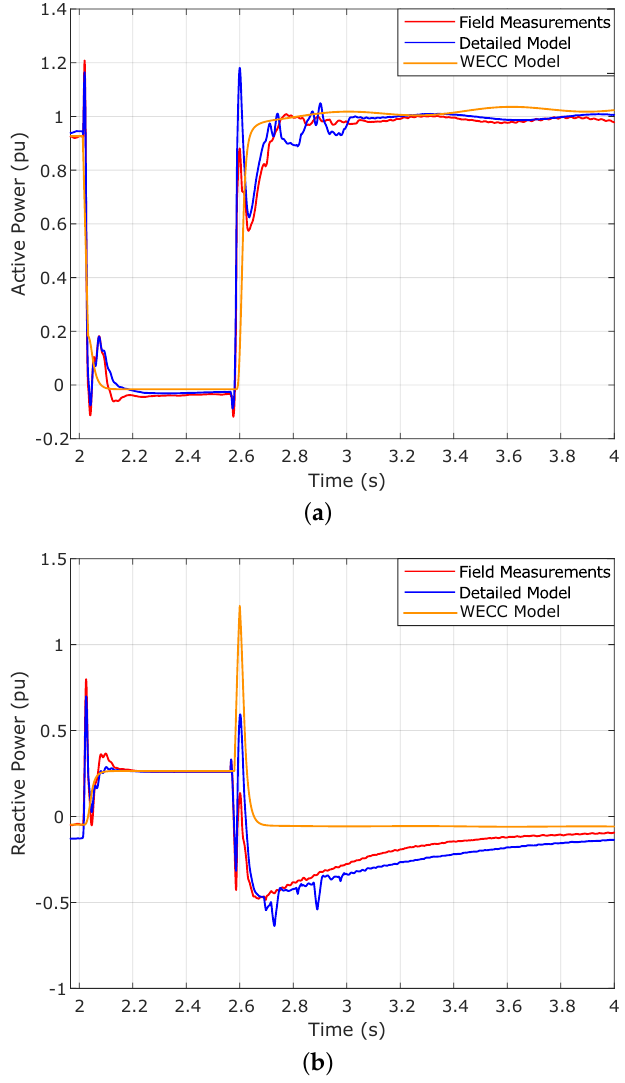
Figure 4. Active and reactive power at measurement point 1 (20 kV). WT operating at full load conditions. ( a ) active power; ( b ) reactive